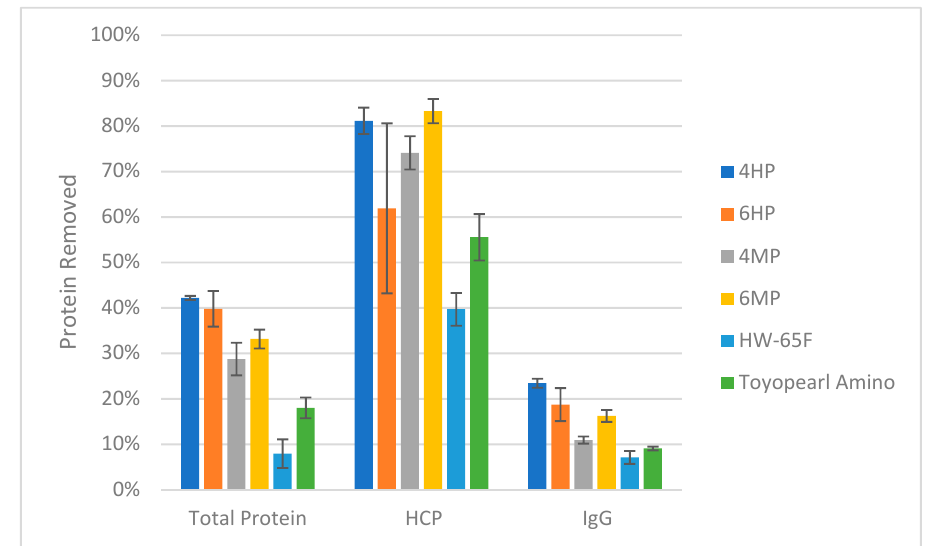
Figure A2. Head-to-head comparison of peptide-coupled resins to Toyopearl AF-Amino-650M and Toyopearl HW-65F polymethacrylate control resins. A representative clarified CHO-K1 mAb production harvest was directly loaded onto the resins at a load of ≈ 5 mg HCP/ mL resin, where HCP, IgG, and total protein removal in the flow-through were further compared to determine the impact of the peptide coupling. Using an analysis of variance for each assay as a function of resin type, a strong correlation between protein binding and the functional group for each of the resins was found ( p < 0.0001, =0.0002, <0.0001 for total protein removal, HCP removal, and IgG removal, respectively).